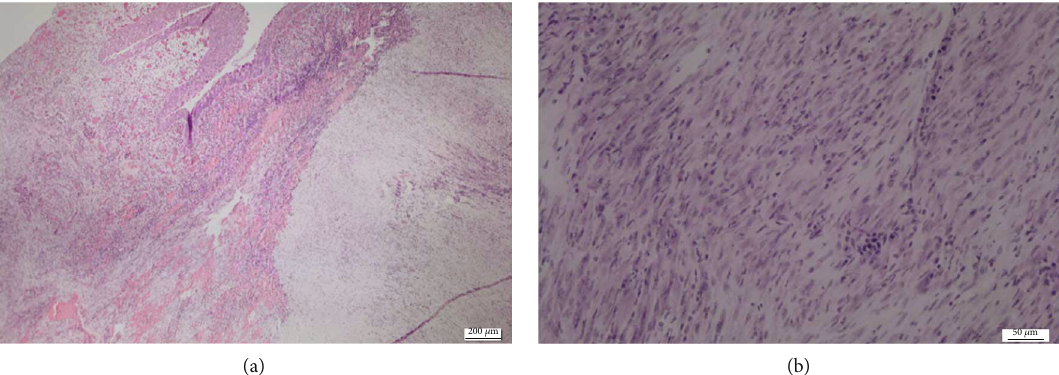
Figure 2: Wright and Giemsa stain demonstrating fusiform spindle cells with cellular atypia and an edematous myxoid stroma under low (a) and high power (b) magni fi